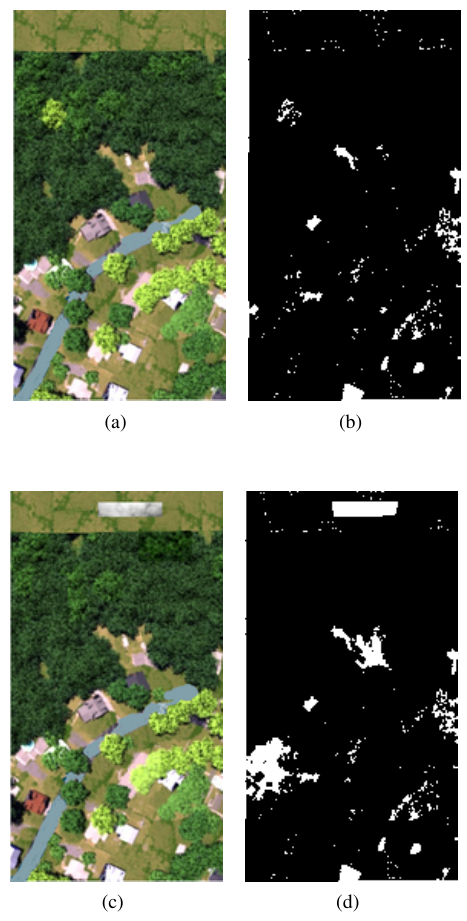
Figure 2: Results of applying PA to the synthetic images.